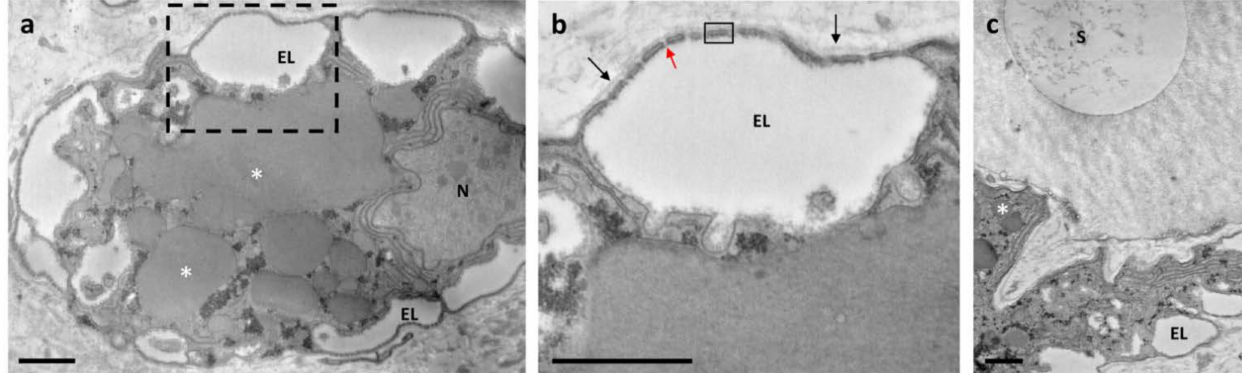
Figure 2. Electron microscopy of rhogocytes found in connective tissue of ampulla. ( a ) Rhogocytes with large nu- cleus (N), several big electron-dense granules (asterisk), abundant endoplasmic reticulum and extracellular lacunae (EL). ( b ) Magnification of the area marked in ( a ) showing EL, cytoplasmic bar (rectangle), diaphragmatic slits (red arrow) and extracellular lamina (black arrows). ( c ) Rhogocyte close to a cell with cytoplasmic spheres (S). Scale bar = 1 µ